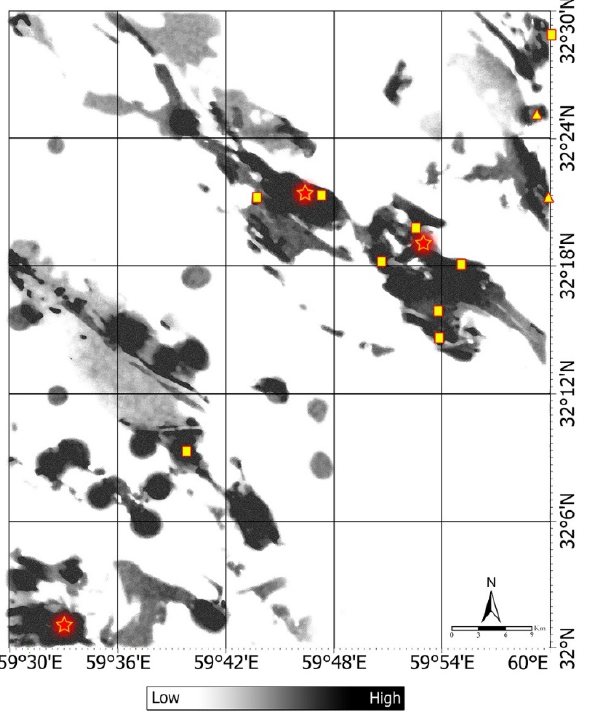
Figure 13. The potential map of copper mineralization for the Sahlabad mining area.